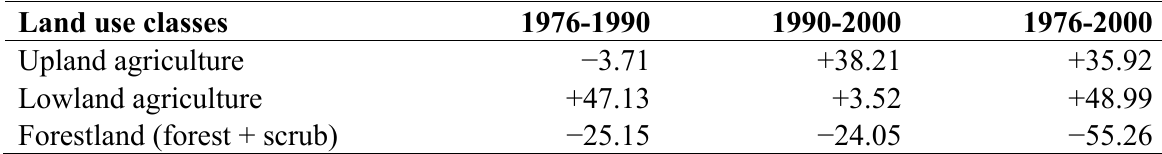
Table 5. Percent change in land use during the three periods, Galaudu watershed,